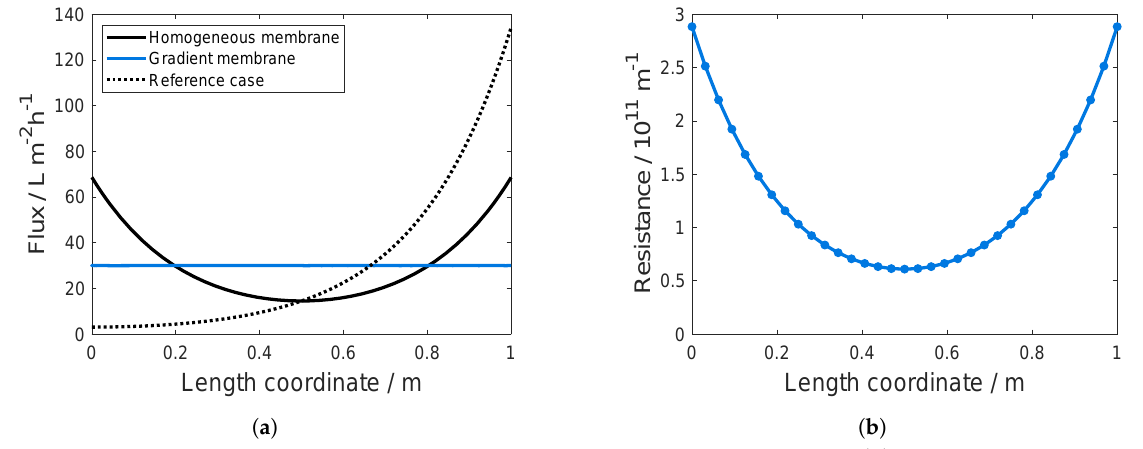
Figure 7. Optimization of double-end setup and comparison to reference case; flux profiles J ( x ) ( a ) and optimized resistance profile R m ( x ) ( b ).